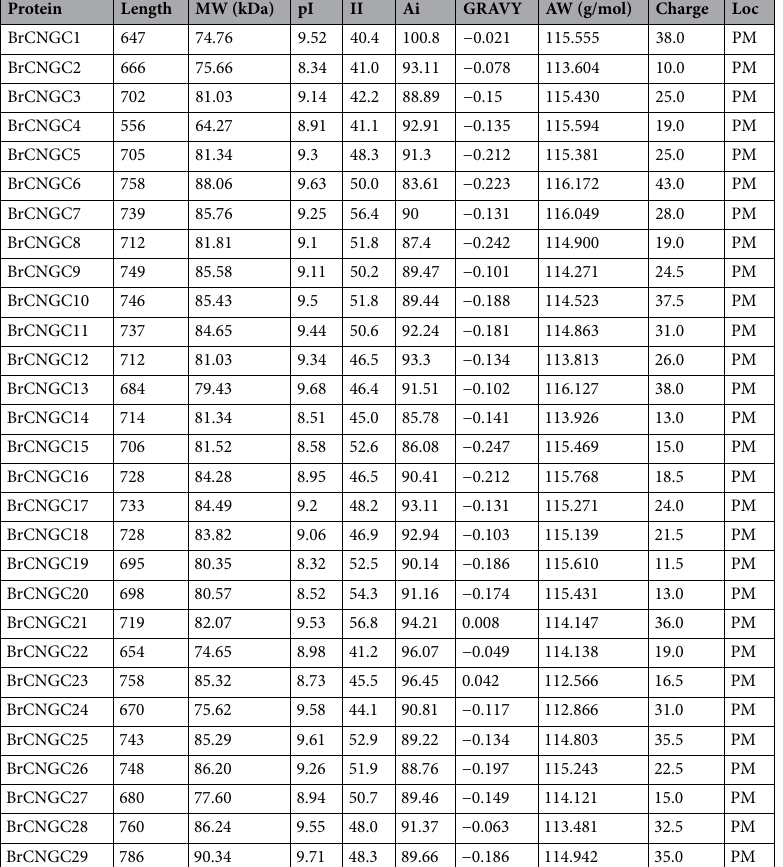
Table 3. Physico-chemical properties and general features of BrCNGC -encoded proteins. MW = Molecular Weight, pI = Isoelectric point, PM = Plasma membrane, II = Instability Index, Ai = Aliphatic index, GRAVY = Grand average of hydropathicity, AW = Average residues weight, Loc =